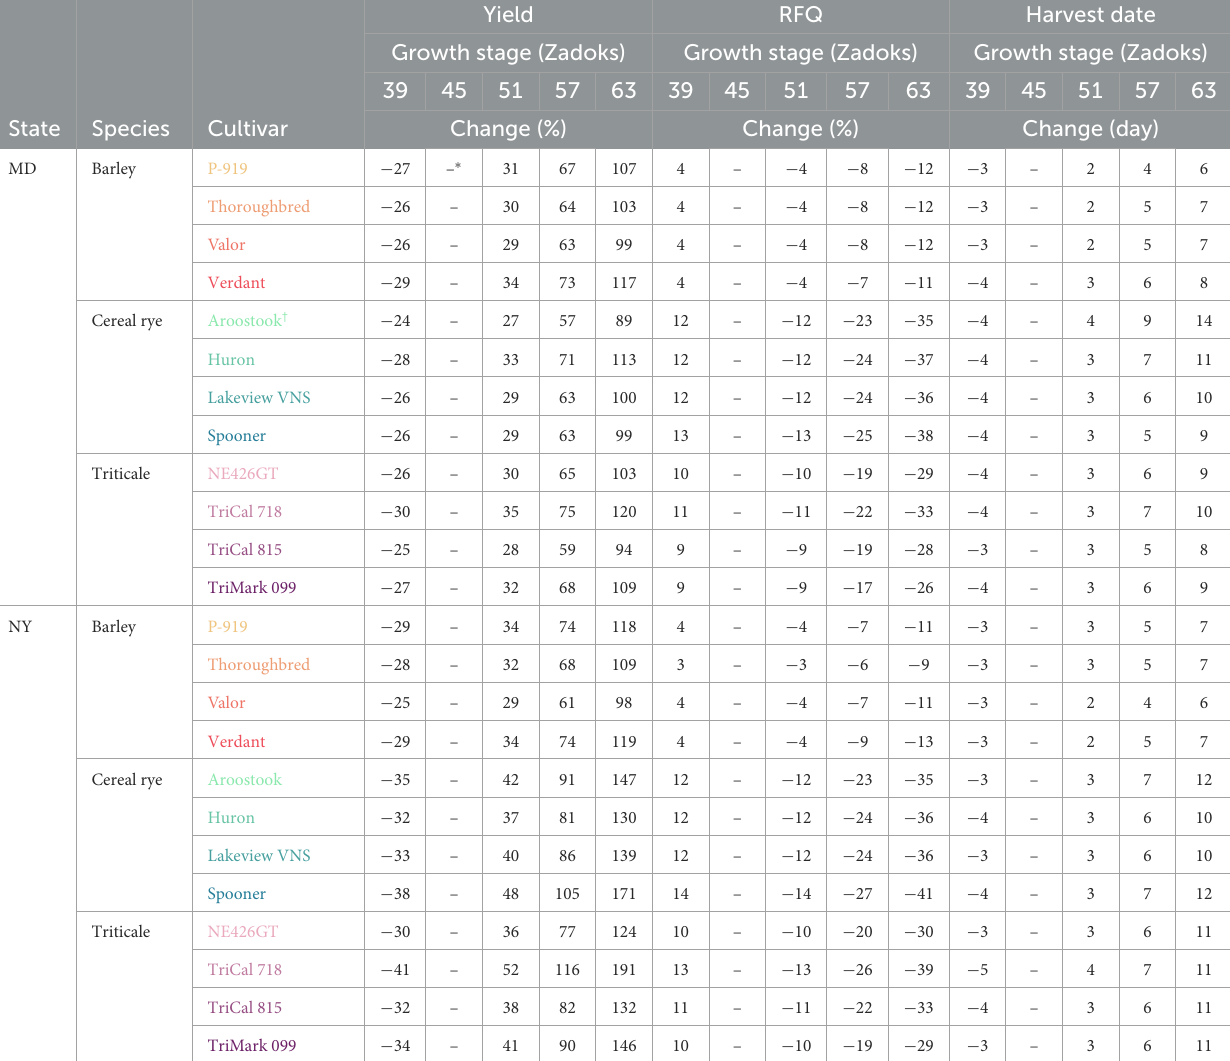
TABLE 3 Change (%) in dry matter yield, change (%) in relative forage quality (RFQ), and change (number of days) in harvest date in relation to a common winter cereal harvest timing of swollen boot stage (Zadoks 45) for all barley, cereal rye, and triticale cultivars in MD and